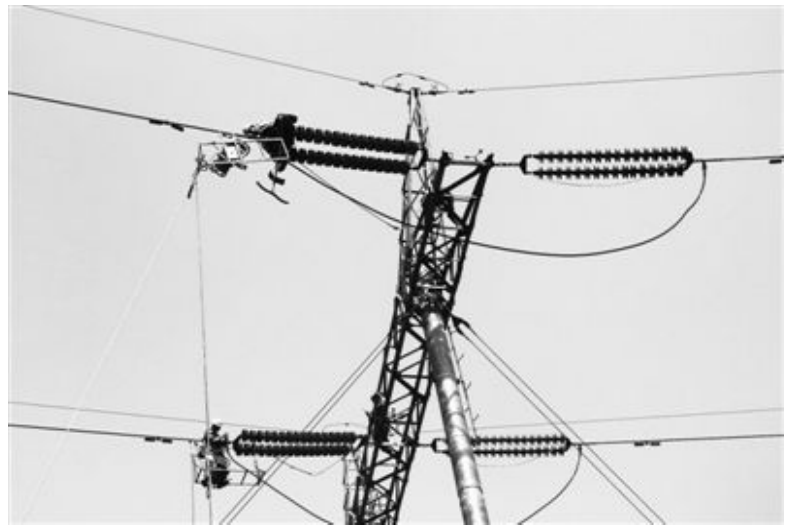
Figure 16. A picture of the jumper cable.